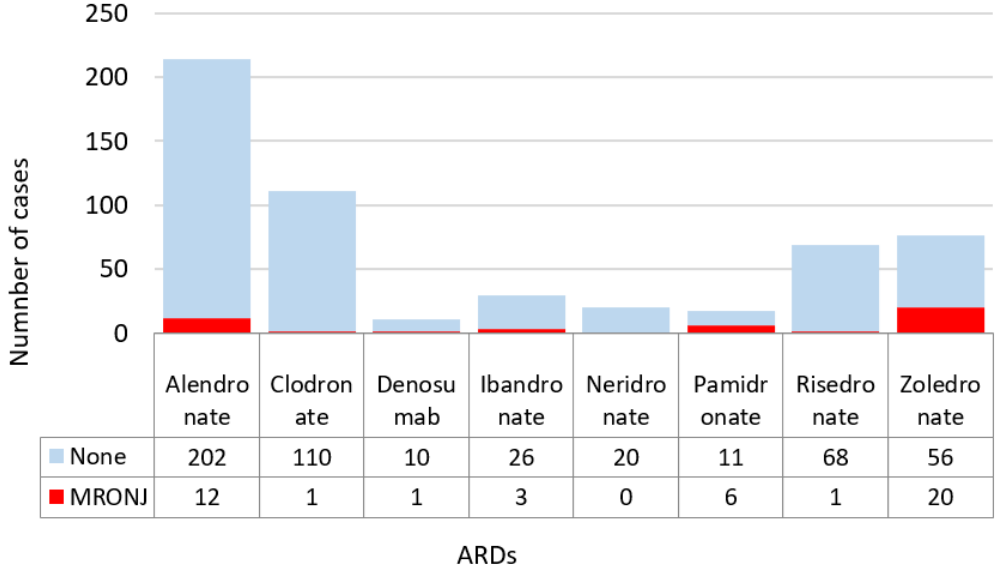
Figure 4. MRONJ incidence by ARDs taken; Figure refers to the total number of drugs taken.